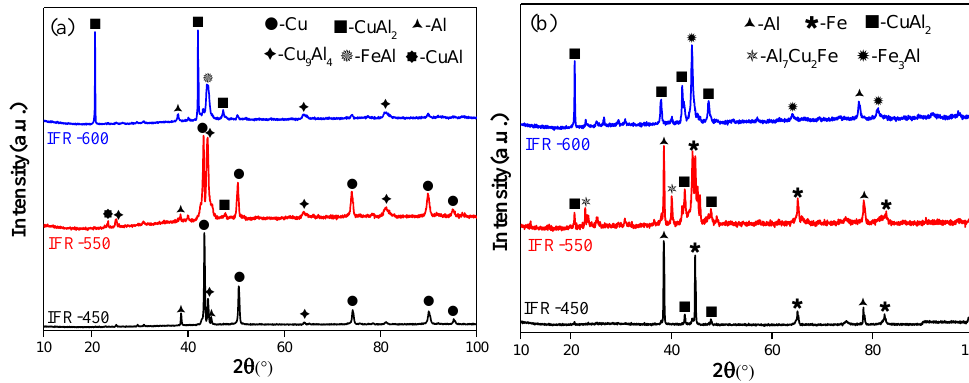
7 of 13 Figure 6. EDS line scan analysis across the Cu/SUS304/Al interface: ( a ) IFR-450, ( b ) IFR-550, ( c ) IFR- 600. 3.3. Peeling Surface of the Clad Sheets The XRD patterns of the peeling surface of IFR samples are provided in Figure 7. It can be seen that the intermediate annealing temperature has a significant impact on the type and content of crystalline phases on the peeling surface. The main crystalline phases in the peeling surface of the Cu side for IFR-450 and IFR-550 are Cu, Al, Cu 9 Al 4, and CuAl 2 .